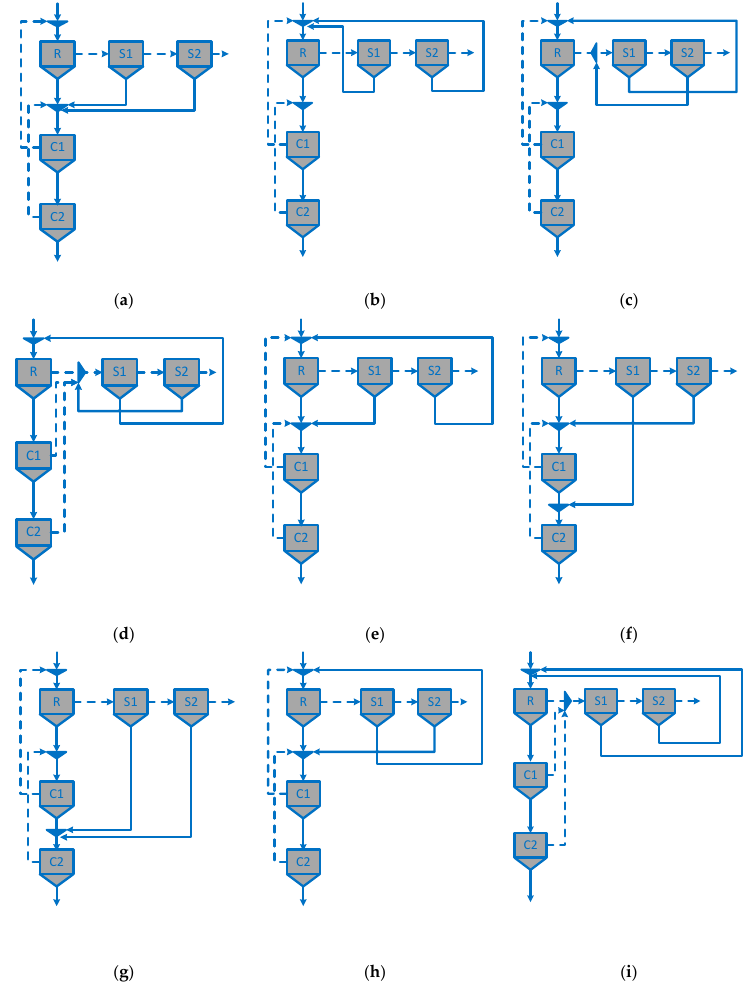
Figure 5. Structures of circuits obtained by maximization of net present worth ( a , c ) or revenues ( c , d , i ) in the case 3.3. Structures ( a , b , e – h ) are obtained by maximization revenues in the case 3.4.